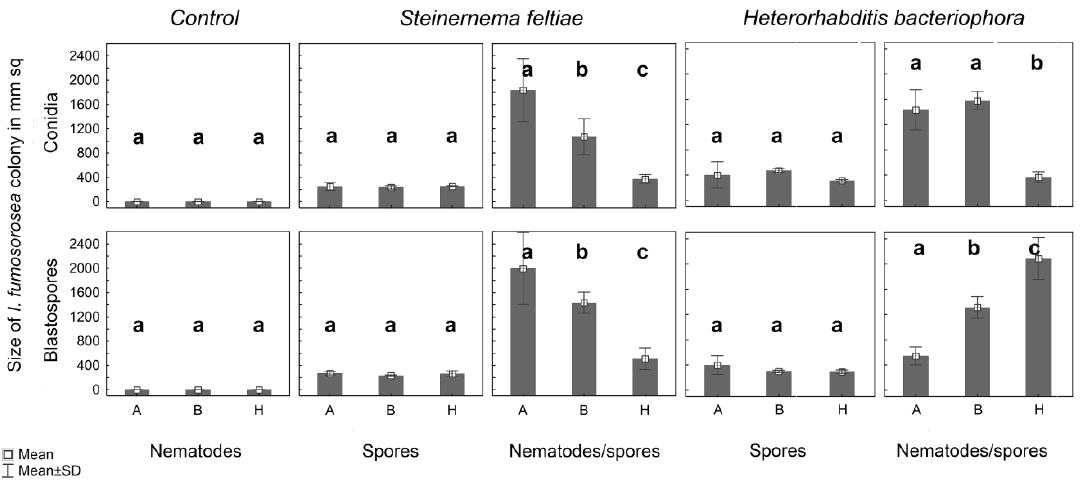
Figure 3. Mean (± SD) area of Isaria fumosorosea colonies in mm 2 . (A) Clean (pure) PDA, (B) PDA with a silver sand barrier, (H) PDA with a silver sand heap. Statistically significant differences are indicated by letters (a, b, c).